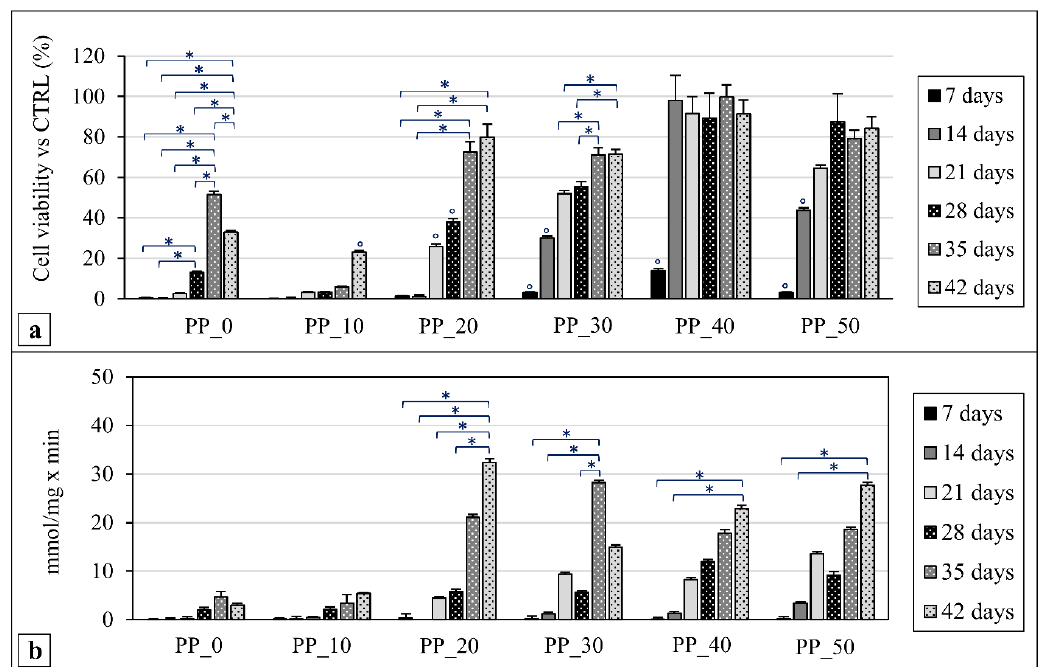
Figure 8. ( a ) MC3T3-E1 cell viability on PHBV/PLGA scaffolds at different time points of cell culture to evaluate the effect of blend composition on cell proliferation over time; ( b ) ALP synthesis as an indicator of MC3T3-E1 cell differentiation towards an osteoblastic phenotype on PHBV/PLGA scaffolds at different time points (three samples for each kind of scaffold were analyzed). The statistical analysis showed in the figures was obtained by comparing the values of scaffolds composed of the same blend at different durations of culture. * Values statistically different ( p < 0.05). ° Data marked with this symbol are statistically different from all the other values obtained for the same blend composition at different experimental points ( p <